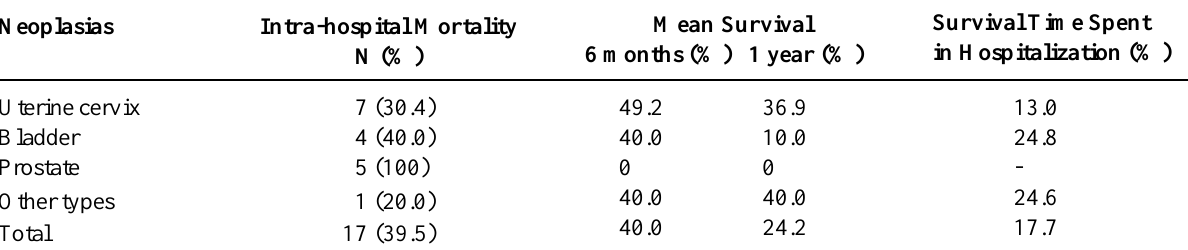
Table 3 – Characteristics in relation to mortality and survival.